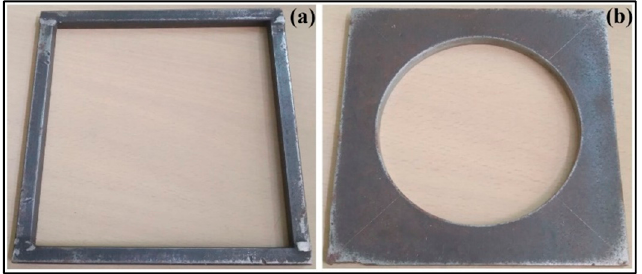
Figure 2. Photographs of dies used for sample preparation: ( a ) mechanical and ( b ) thermal.